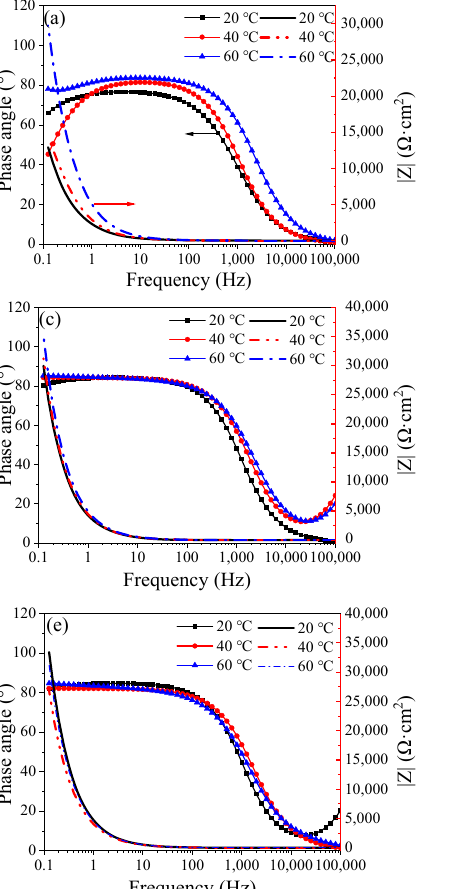
Figure 7. Bode plots of change with the duration of passivation time: ( a ) 0.5 h, ( b ) 6 h. ( c ) 12 h, ( d ) 24 h, ( e ) 48 h, and ( f ) 240 h. Table 3. EIS fitting parameters of Q235 carbon steel at different temperatures and passivation times.